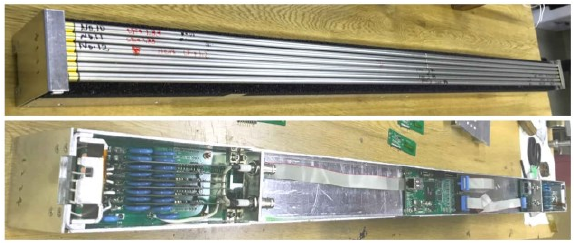
Fig. 1. PSD system of 1 m length and 8 mm diameter .